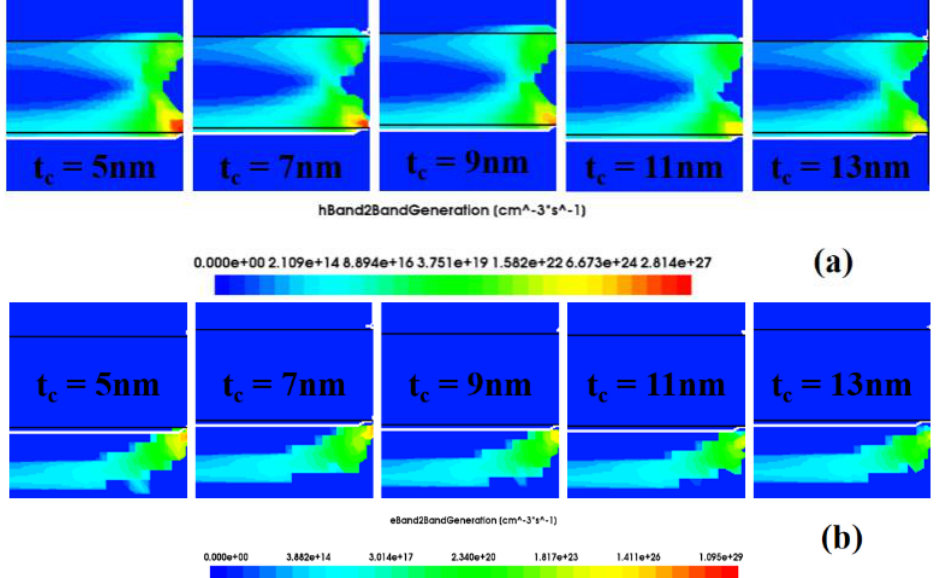
Figure 6. ( a ) The hole generation rate and ( b ) electron generation rate in the source and channel regions on the left side of the DM − SSTGTFET biosensor under different thicknesses of nanogap. 3.3. Different Charged Biomolecules The biomolecules discussed above are all neutral molecules and are not charged. Therefore, it is necessary to consider different charged biomolecules. The different charge densities investigated in this paper are 5 × 10 11 cm − 2 , 1 × 10 12 cm − 2 and 1.5 × 10 12 cm − 2 . As shown in Figure 7, the smaller the k value, the greater the change in the transfer curve, energy band, threshold voltage sensitivity and drain current sensitivity under different charged